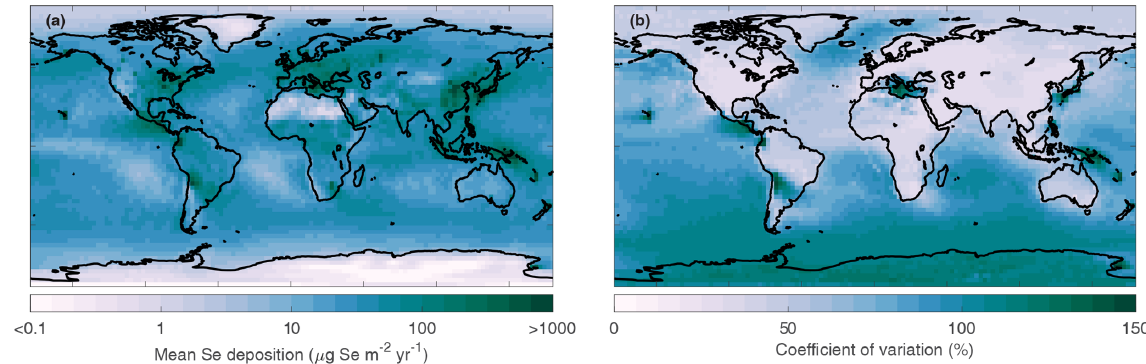
Figure 8. Map of the mean Se deposition (a) and associated coefficient of variation (b) , calculated by resampling surrogate models of deposition in each grid